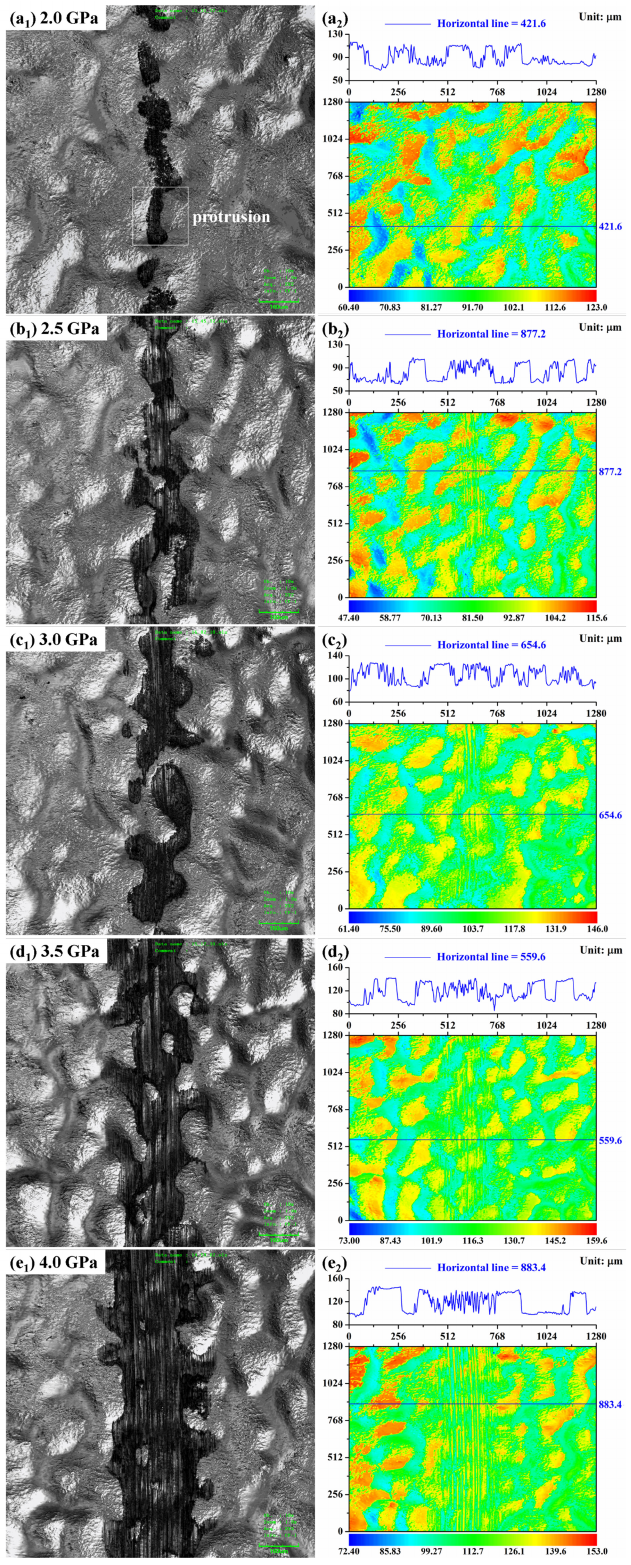
Figure 7. LCSM wear topographies of HCPEB-treated Ta coating after sliding in pure JP-10 against a Si 3 N 4 ball at room temperature in ambient atmosphere: ( a 1 – e 1 ) LCSM images under 2.0–4.0 GPa, respectively; ( a 2 – e 2 ) corresponding contour graphs of ( a 1 – e 1 ),